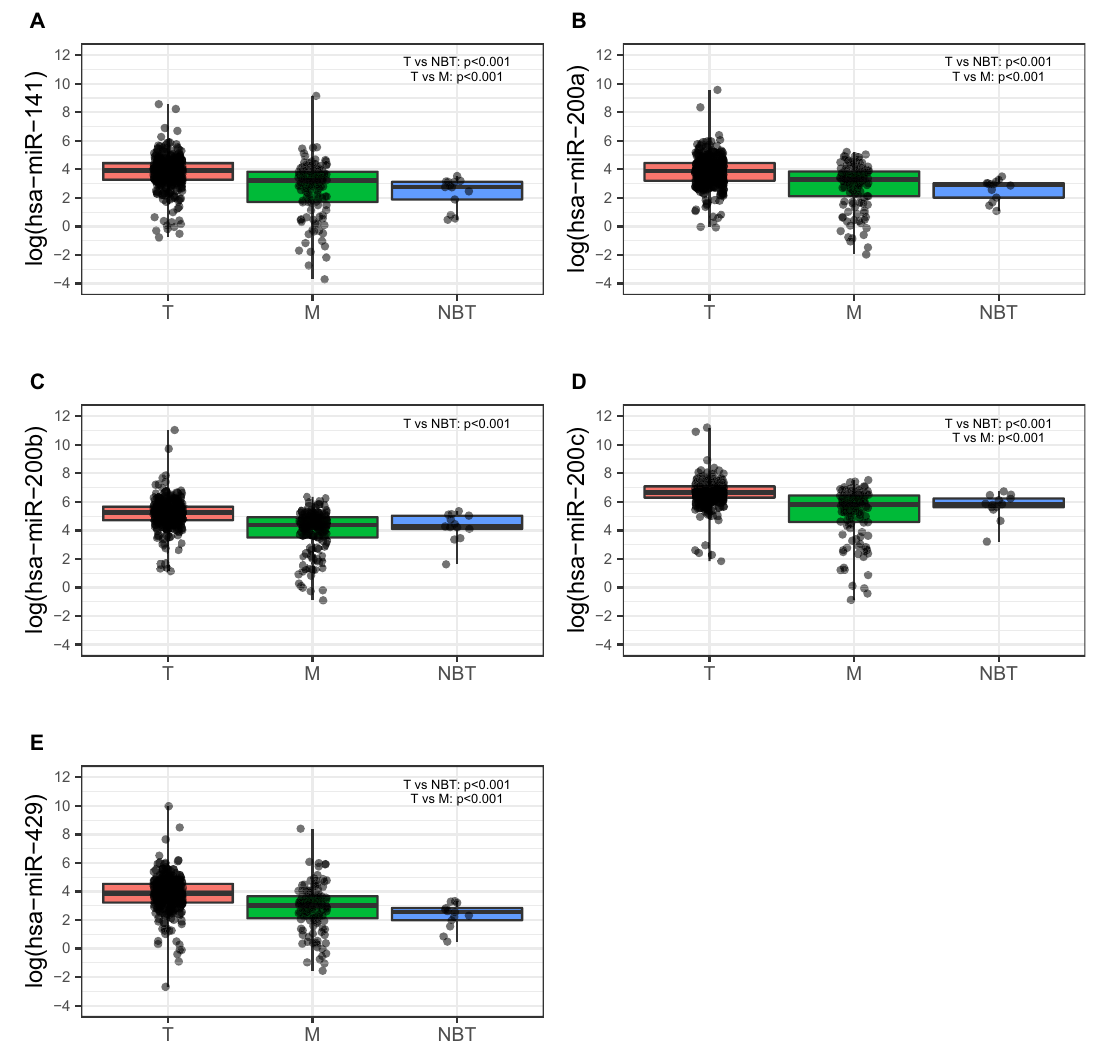
Figure 1. miR-200 family members expression in H-CSS cohort in tumor tissues (T), normal breast tissues distant from tumor (M) and normal breast tissue from reductive mammoplasty (NBT). Plots were performed using the R Foundation for Statistical Computing (version 3.6, packages: ggplot2,